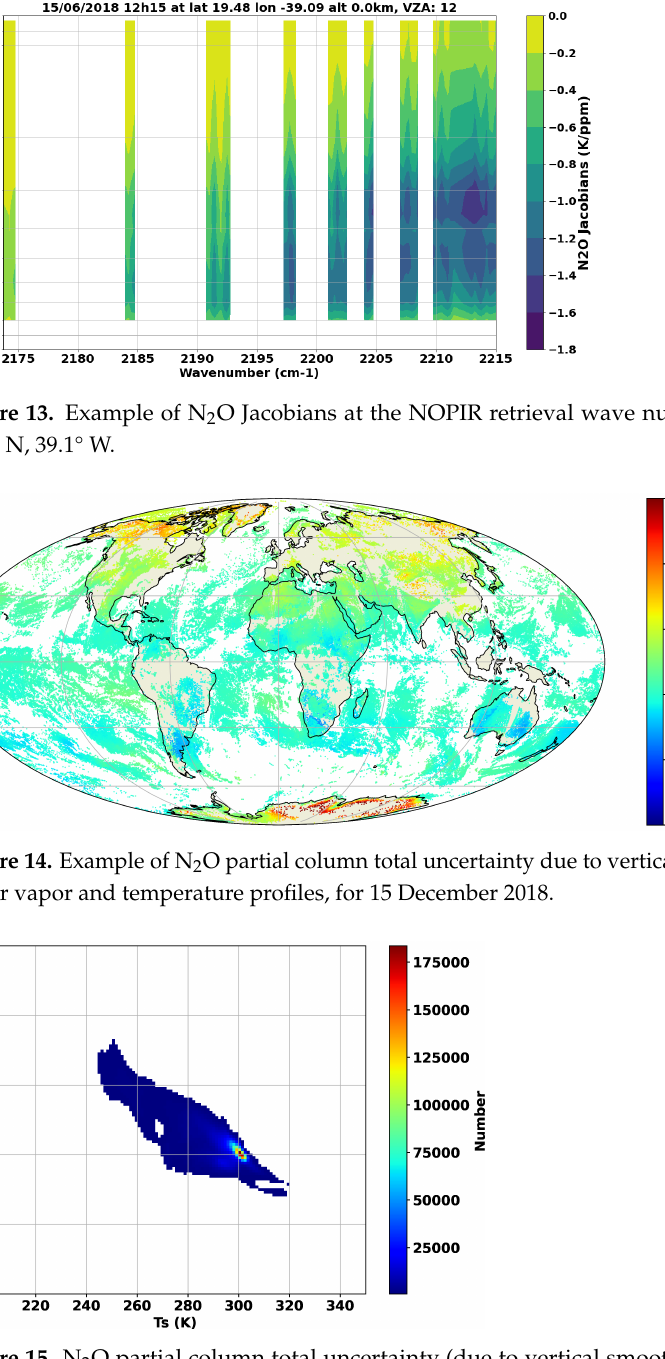
Figure 15. N 2 O partial column total uncertainty (due to vertical smoothing, spectral noise, water vapour and temperature profiles) correlation with surface temperature, for 15 December